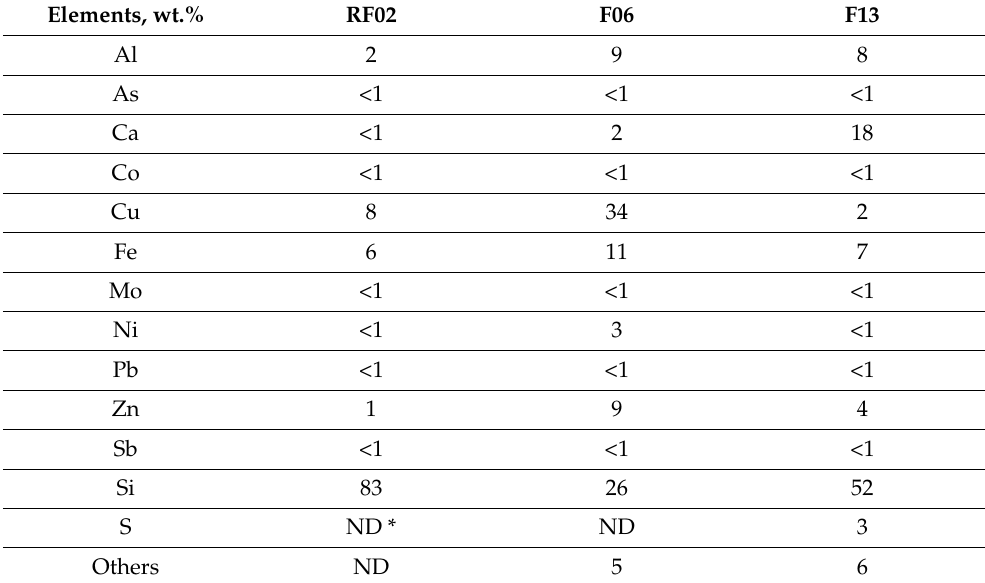
Figure 8. XRD patterns of precipitates of RF02, F06, and F13 from dynamic leaching: ( a ) bottom precipitate; ( b ) red precipitate. SH = sample holder. Table 3. Quantitative screening of dynamic leaching boiler precipitates using ICP–MS (SD ± 30 wt.%); *, not